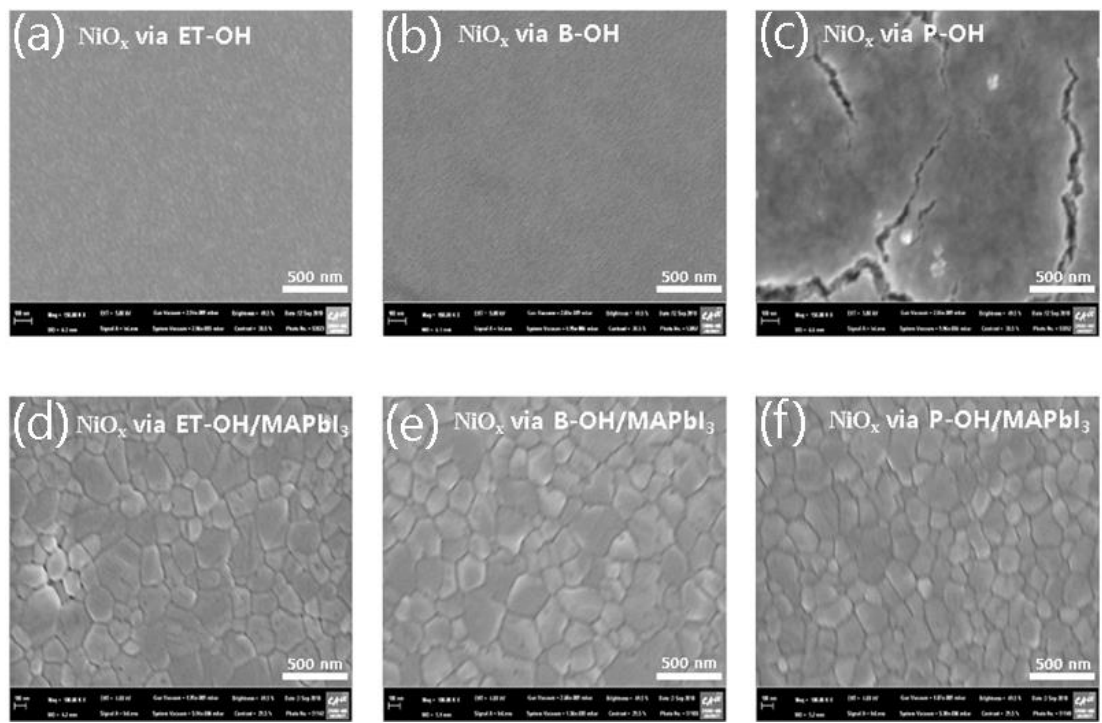
Figure 3. FE-SEM of ITO/NiO x (sol-gel) via solvent: ( a ) ET-OH, ( b ) B-OH, ( c ) P-OH and MAPbI 3 on ITO/NiO x (sol-gel) via solvent, ( d ) ET-OH, ( e ) B-OH, and ( f ) P-OH.